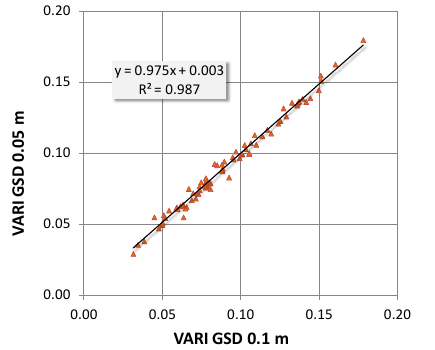
Figure 6. Correlation of vegetation index VARI computed from 5 cm and 10 cm GSD